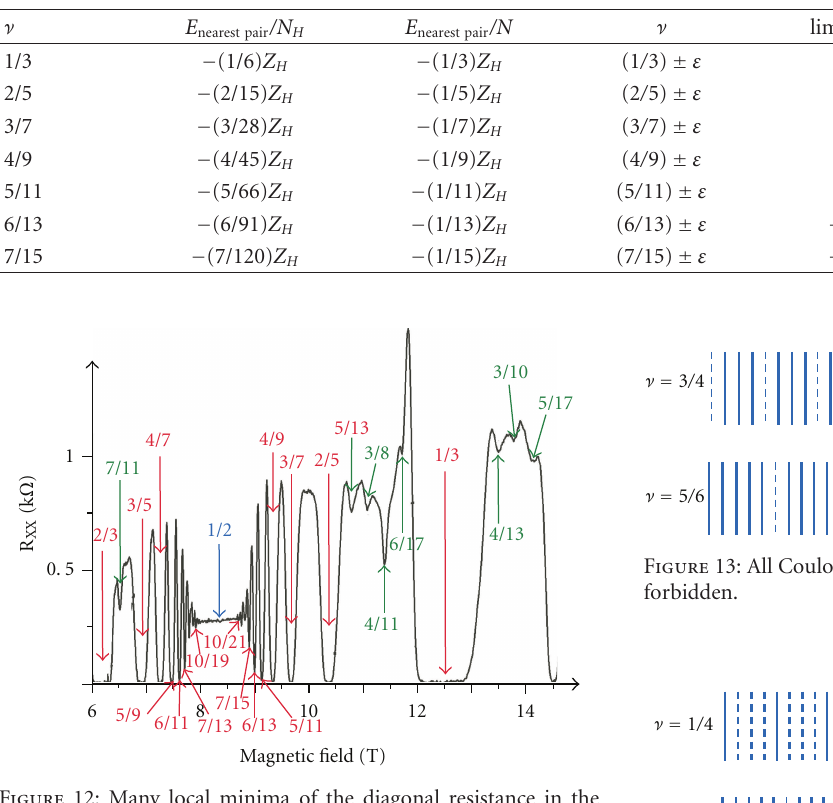
Figure 12: Many local minima of the diagonal resistance in the region of 2 / 3 ≥ ν ≥ 1 / 3. This experimental result has been obtained in [2].